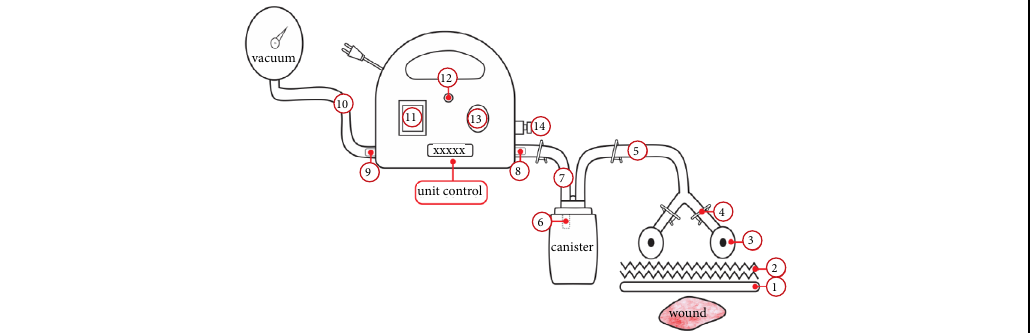
Figure 3 - SVDM setup. (1) Foam; (2) Adhesive film (polyurethane); (3) Suction cup; (4) Clip cuts flow; (5) Drainage tube; (6) Filter; (7 and 10) Connecting tubes; (8) Air inlet; (9) Air outlet; (11) Timer